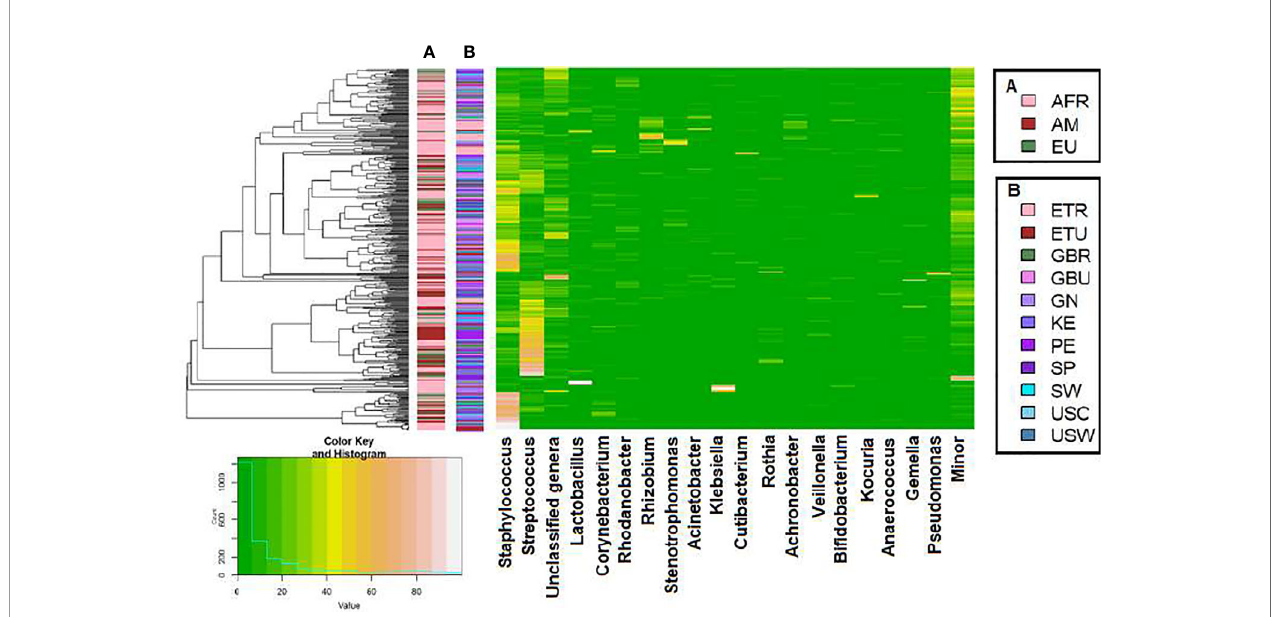
FIGURE 3 | Heatmap plot representing the hierarchical clustering, at the genus level, of the milk samples by continent cohorts (A) and by location cohorts (B) analyzed in this work with the SILVA 138